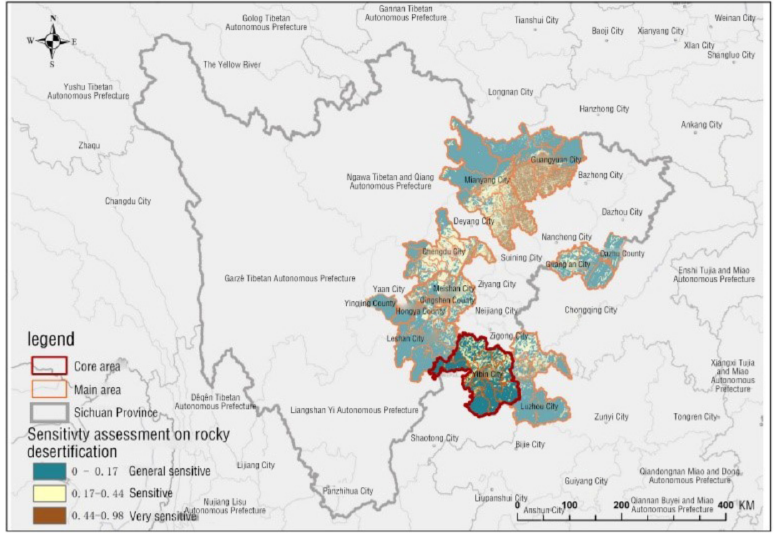
Figure 14. Sensitivity assessment on rocky desertification in research areas of Sichuan